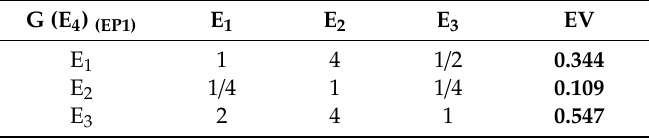
Table 2. Pairwise comparison and eigenvector (EV) values of E 1 , E 2 and E 3 by expert 1 targeting target G (E 4 ).